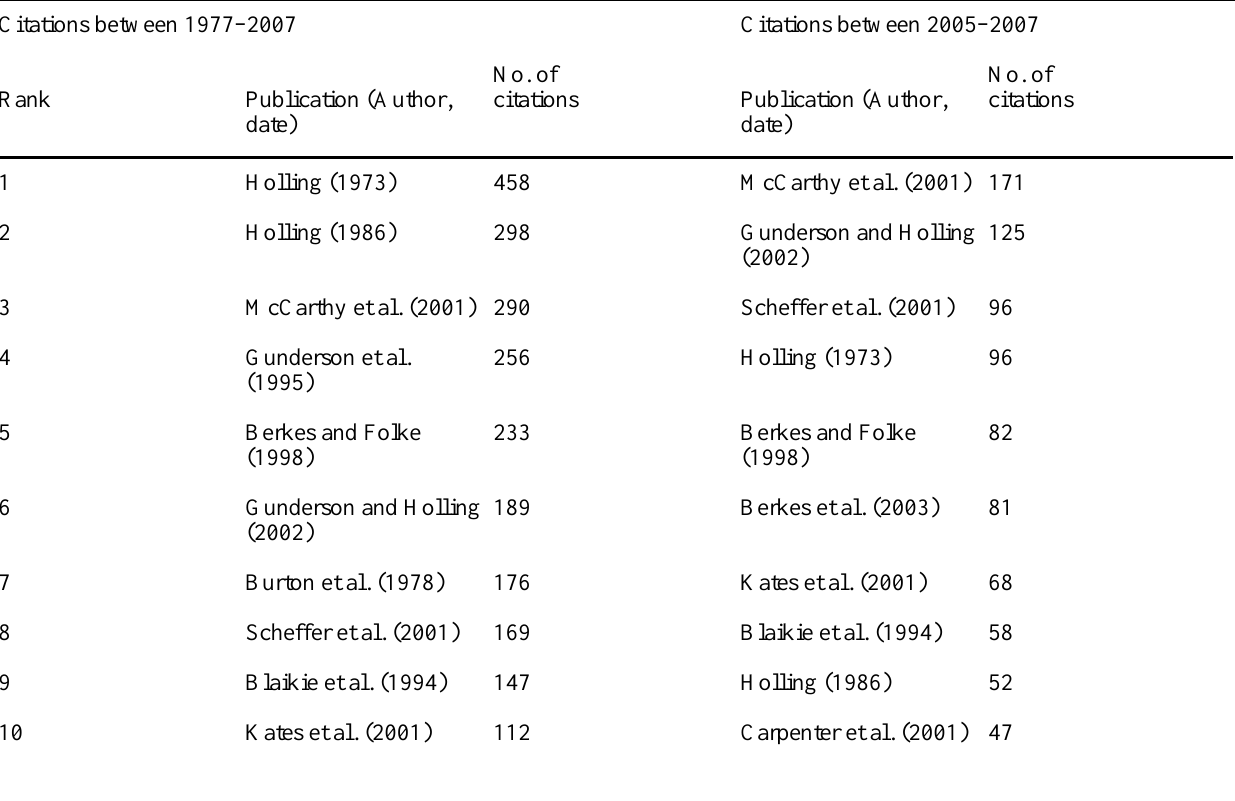
Table 2. The top ten cited publications in the database over the period 1977–2007 (left) and the period 2005–2007